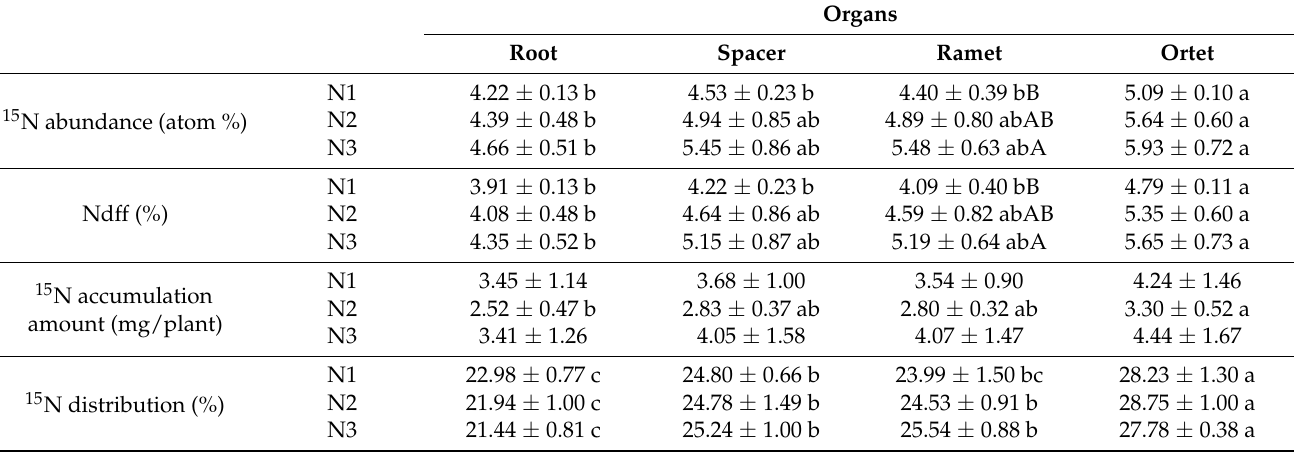
Table 2. 15 N values and 15 N allocation of buffalograss seedlings, as affected by nitrate, ammonium, and ammonium nitrate. Each value is the mean ± SD. The values not sharing the same letters are significantly different at p < 0.05 according to Duncan’s test of one-way ANOVAs. CK, -NH 4 NO 3 ; N1,